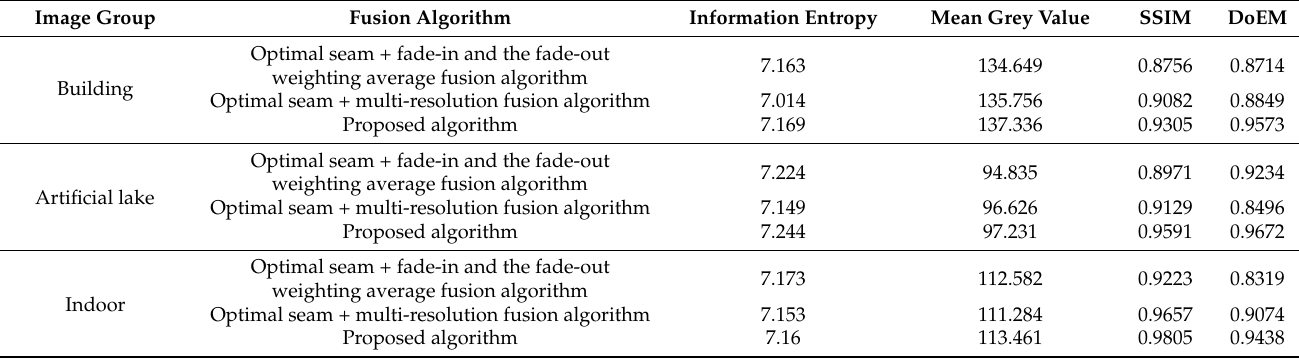
Table 2. Quality evaluation of fused